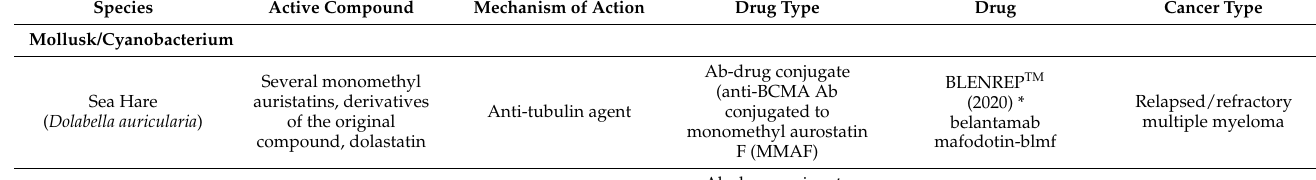
Table 1. Approved marine-derived drugs currently on the market for cancer therapy (as reviewed in [36]). Abbreviations: BCMA for B-cell Maturation Antigen, Ab for antibody, MMAF for monomethylauris- tatin F, MMAE for monomethylauristatin E and eEF1A for eukaryotic translation elongation factor 1 alpha 1. * FDA-approved. **